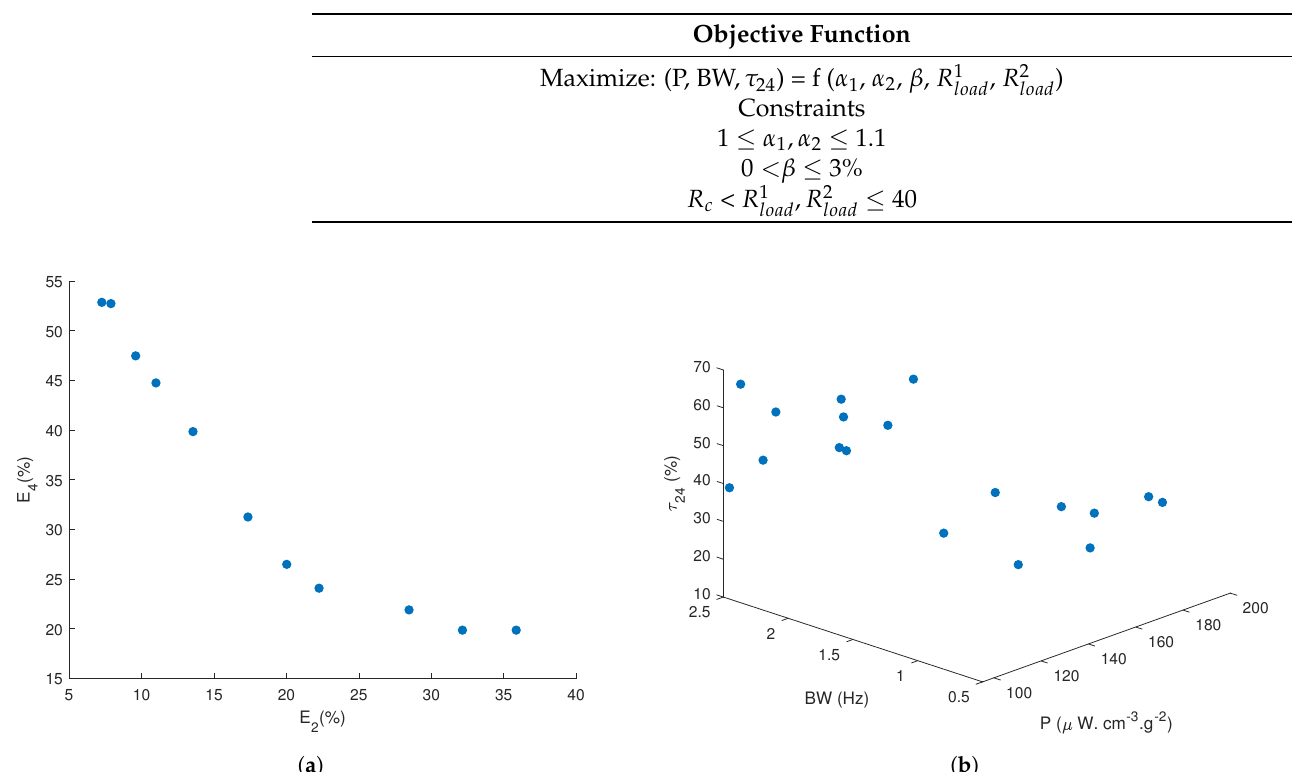
Table 5. Objective function and constraints applied to the optimization problem for the 5-DOFs harvester.